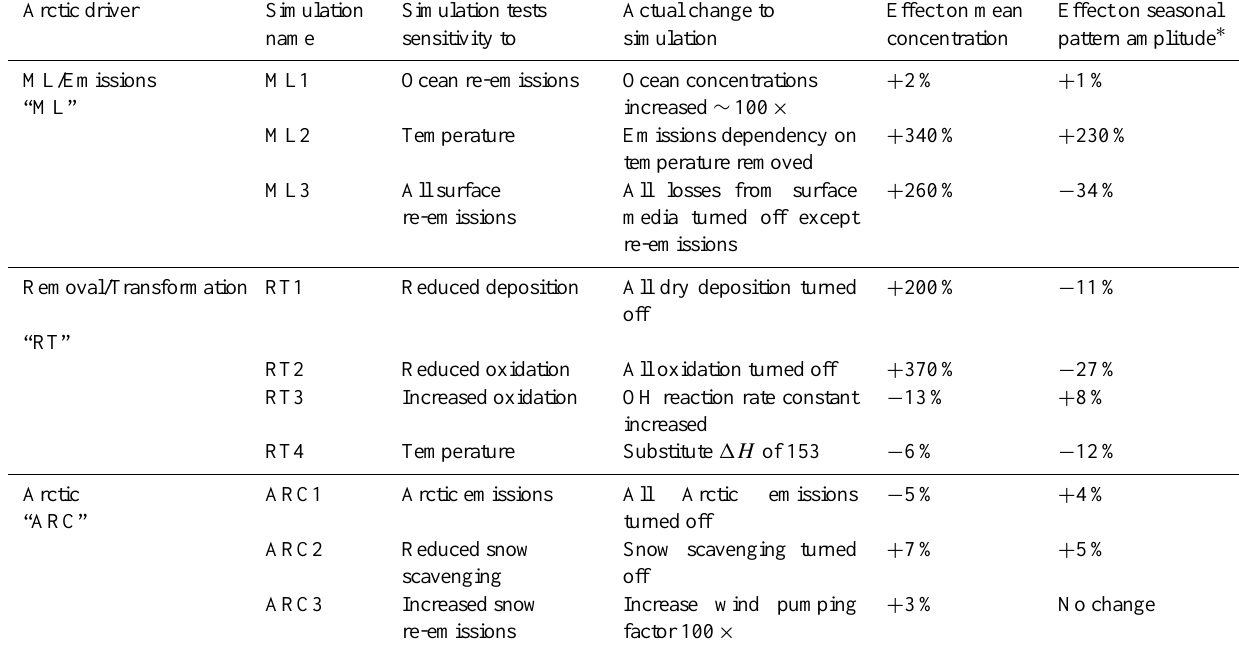
Table 5. Results of sensitivity simulations on mean surface atmospheric CB 28 Arctic concentrations. ∗ Measured by taking the ratio of mean January normalized concentrations. Simulations that increase the mean concentration while simultaneously decreasing the seasonal pattern amplitude (simulations ML3, RT1, and RT2) are those that bring model and observational results closer